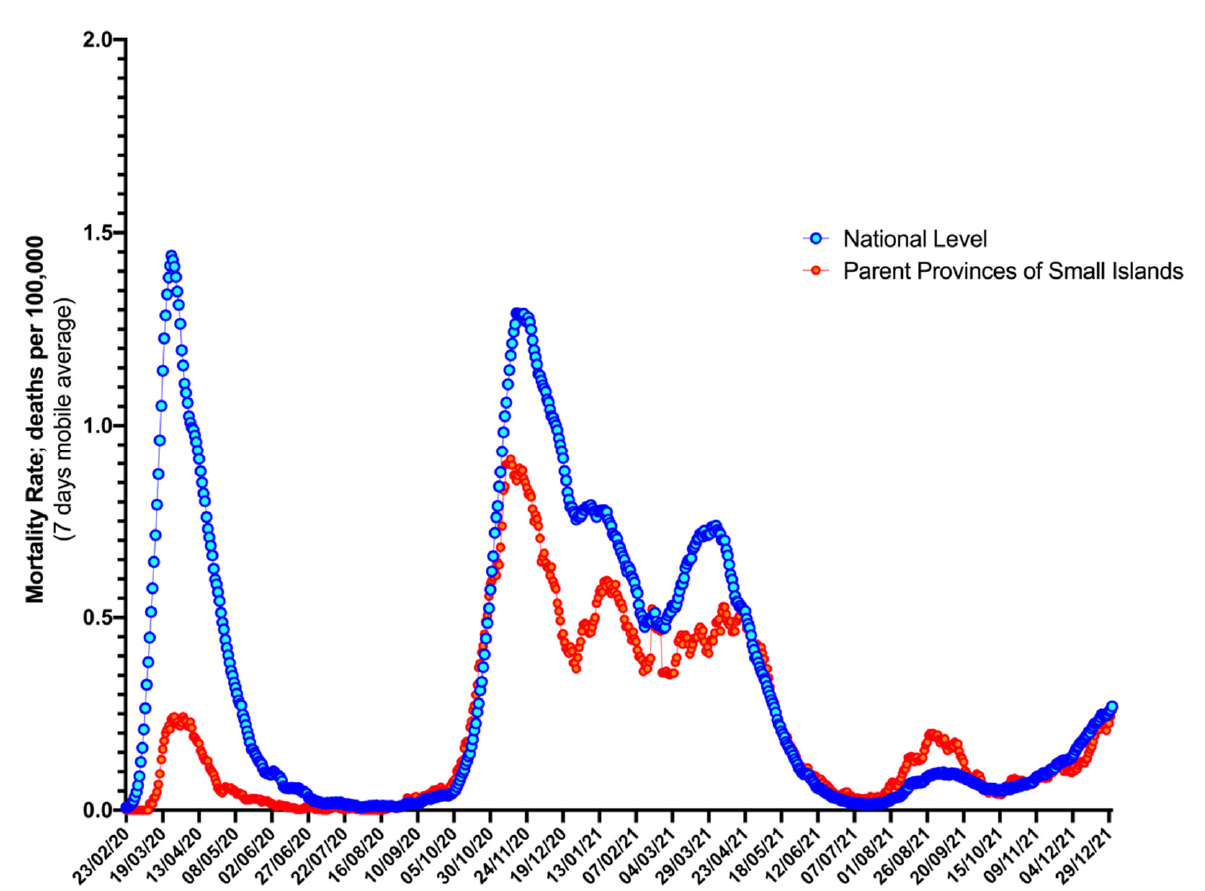
Figure 4. Mortality rates (7-day moving average) in parent provinces of Italian small islands, and at national level (25 February 2020; 31 December 2021). Both individual (Figure 6a) and pooled monthly EMR estimates for the small islands (Figure 6b) were positively correlated with the estimates for the parent provinces (respectively: rho = 0.416, p = 0.013, and rho = 0.592, p = 0.002). However, pooled estimates were unrelated with the national level (rho = 0.351, p = 0.351). EMR was also unrelated with population density (rho = 0.231, p = 0.181), and with demographic factors such as the share of individuals aged 60 years or more (rho = − 0.007, p = 0.966), or 80 years or more (rho = 0.055, p = 0.754), or average per capita income (rho = 0.277, p =